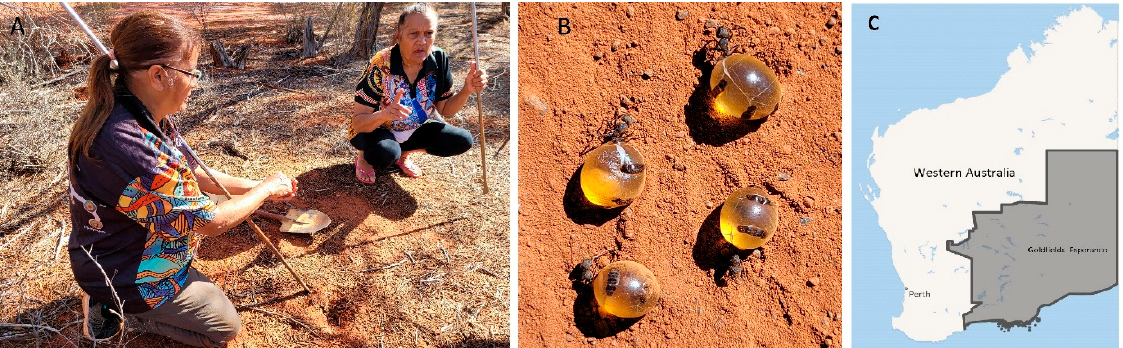
Figure 2. E. Ulrich and her sister Margorie Stubbs ( A ) collecting honeypot ants ( B ) about 50 km east of the city of Kalgoorlie in Western Australia’s Goldfields region ( C ).